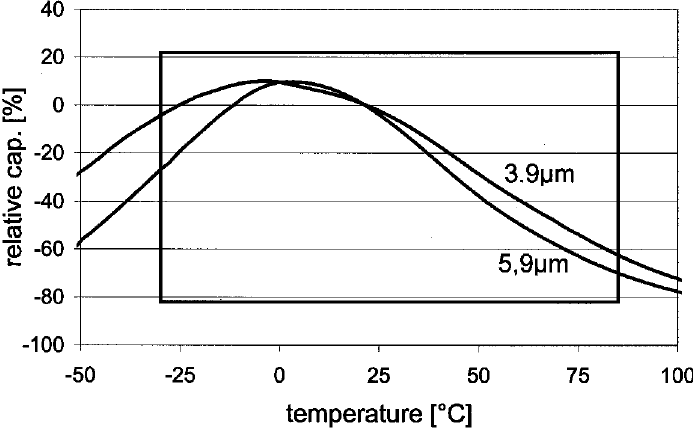
FIGURE 8 TCC of new BME-Y5V materials under development.